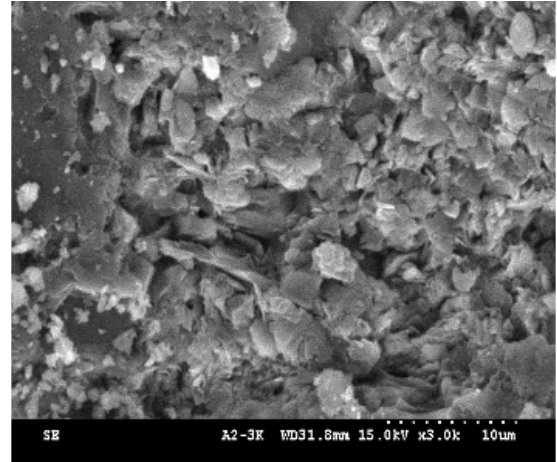
Figure 8. SEM photo of the control